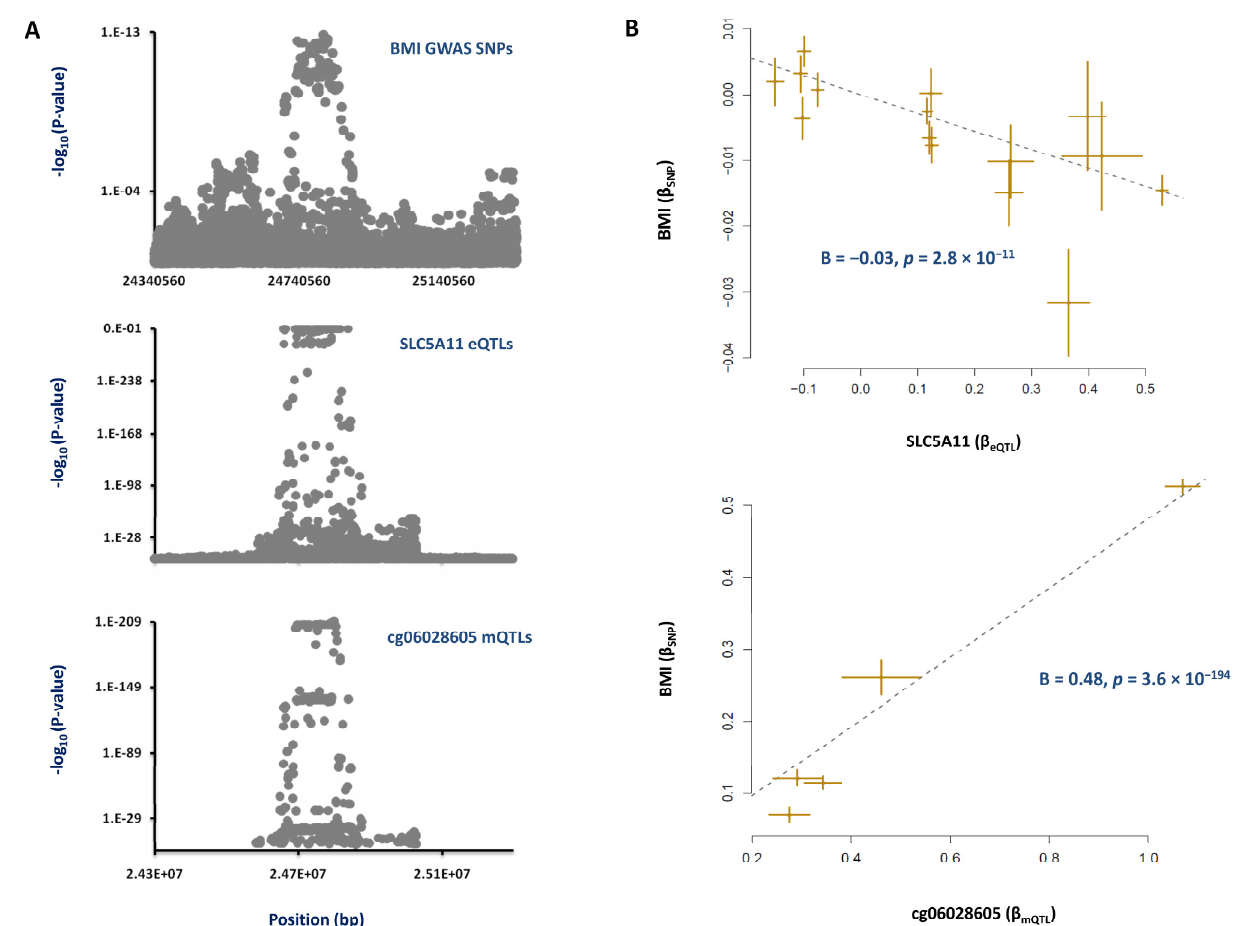
Figure 3. Mechanism whereby the cg06028605 site inside SLC5A11 impacts obesity. ( A ) We found that the regional association plots for mQTLs of cg06028605, eQTLs of SLC5A11 and risk SNPs of obesity co-localize. ( B ) MR analysis then revealed that, as the cg06028605 site becomes hypermethylated, the expression of SLC5A11 increases, and this contributes to a lower BMI. Each point on the MR plots represents a SNP; the x-value of a SNP is its β effect size on the exposure, and the horizontal error bar represents the standard error around the β. The y-value of the SNP is its β effect size on the outcome, and the vertical error bar represents the standard error around its β. The dashed line represents the line of best fit (a line with the intercept of 0 and the slope of β from the MR test).